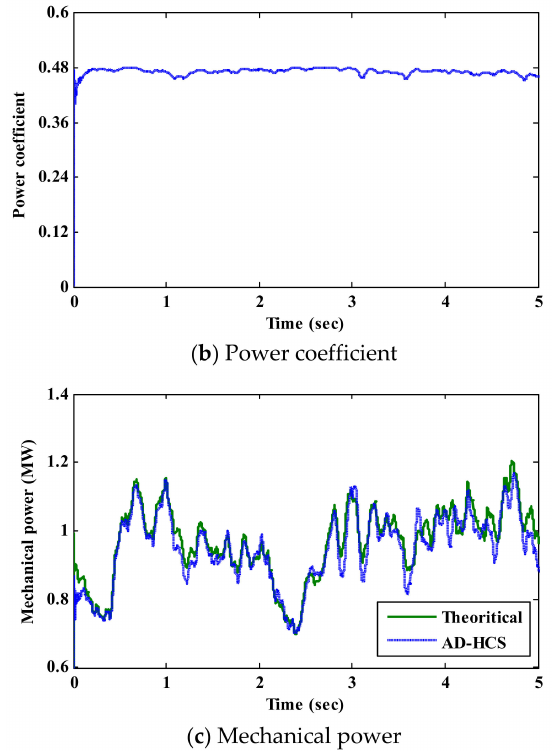
Figure 10. Simulation results under random wind speed.